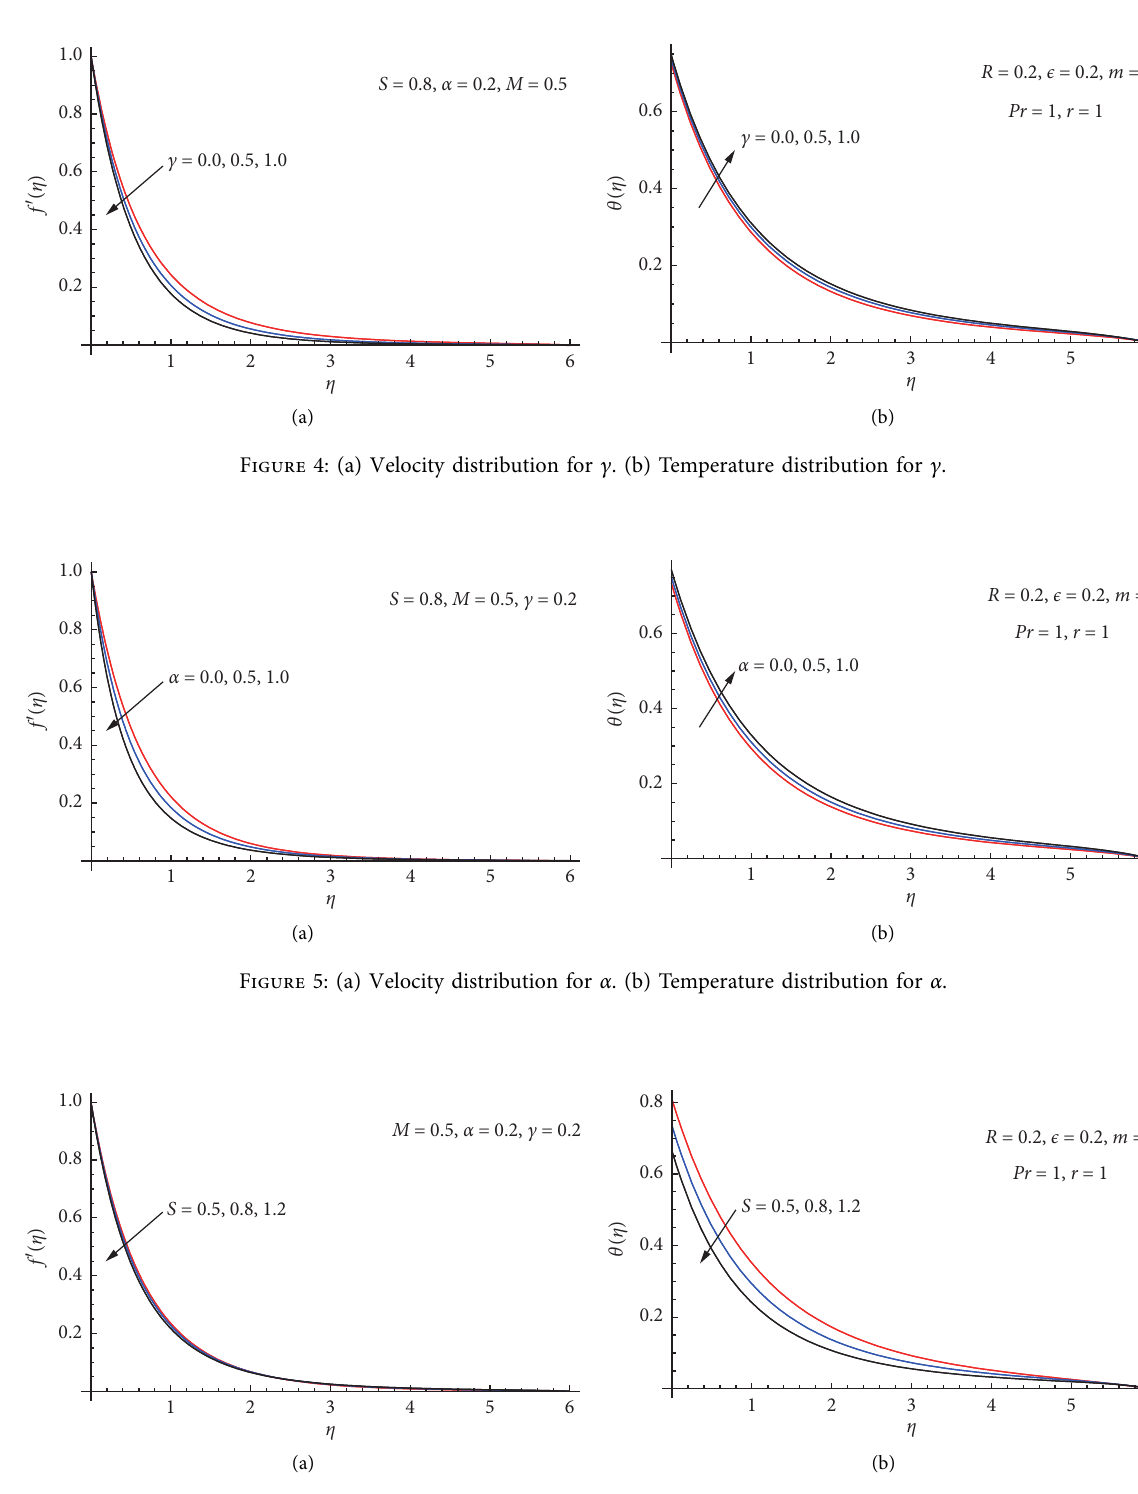
Figure 6: (a) Velocity distribution for S . (b) Temperature distribution for S show the effect of c on the stream line pattern. The same behavior of the stream line pattern for altering the parameter is similar to the magnetic parameter M .